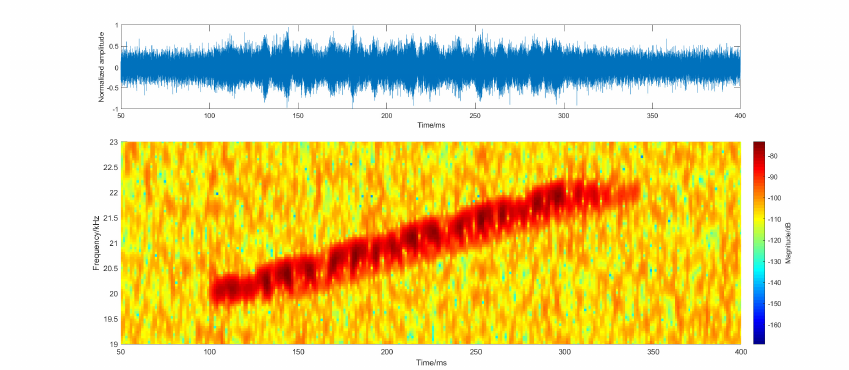
Figure 5. The waveform of received signal.